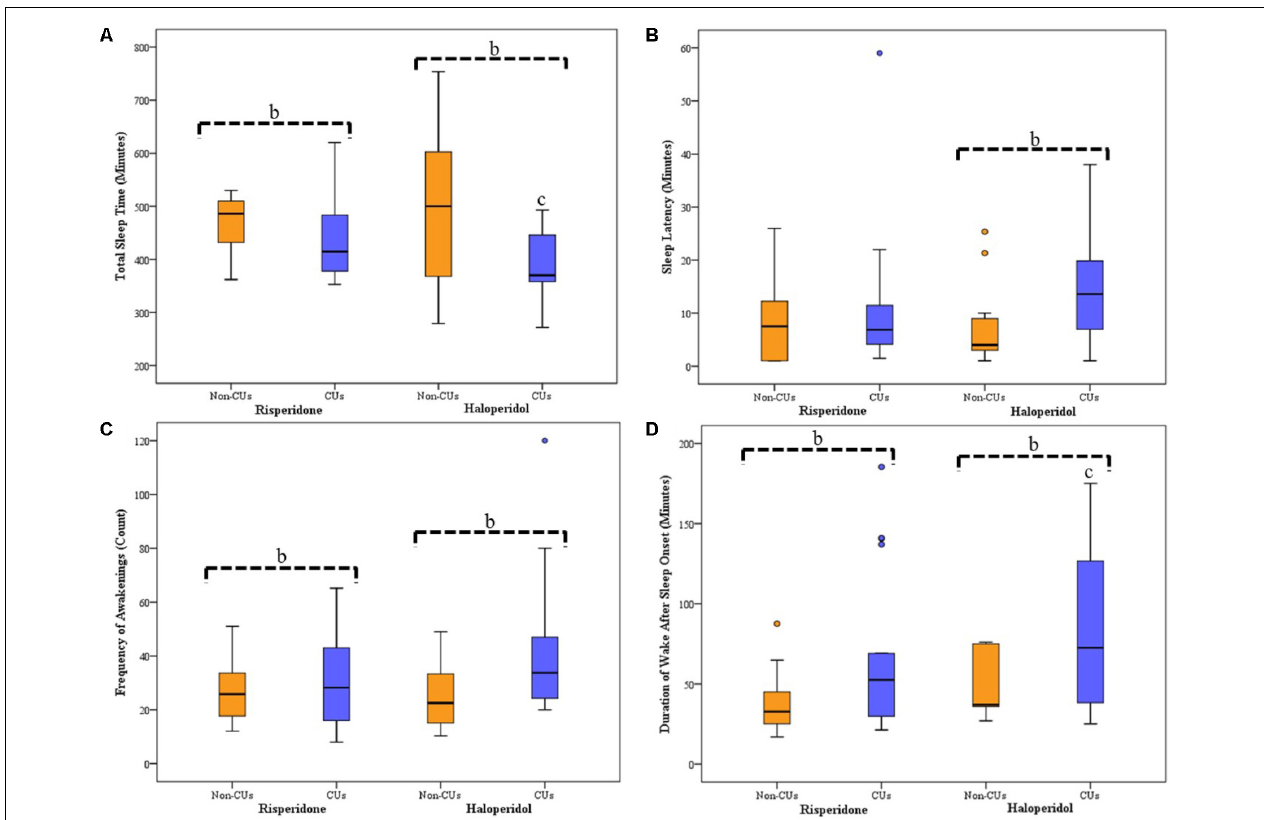
FIGURE 1 | Average Sleep for Seven Consecutive Nights of Actigraphy Recording for CU and Non-CU Receiving either Haloperidol or Risperidone. Box-plots represent median (thick, dark horizontal lines), IQR (boxes), minimum and maximum (whiskers) of each sleep parameter recorded using actigraphy. Circles represents outliers in sleep data. b Significant differences between CU and non-CU groups. c Significant difference between CU treatment groups. (A) TST was significantly less for CU than non-CU when receiving either haloperidol ( p = 0.015) or risperidone ( p = 0.035); there was significantly less TST between CU receiving haloperidol and CU receiving risperidone ( p = 0.045). (B) SL was significantly longer for CU than non-CU when receiving haloperidol ( p = 0.009), but not when receiving risperidone. (C) Frequency of awakening after sleep onset was significantly more for CU than non-CU when receiving either haloperidol ( p = 0.017) or risperidone ( p = 0.004). (D) WASO duration was significantly longer for CU than non-CU when receiving either haloperidol ( p = 0.005) or risperidone ( p = 0.020); there was significantly longer WASO between CU receiving haloperidol and CU receiving risperidone ( p = 0.022). CU, Cannabis user; non-CU, non-user of Cannabis